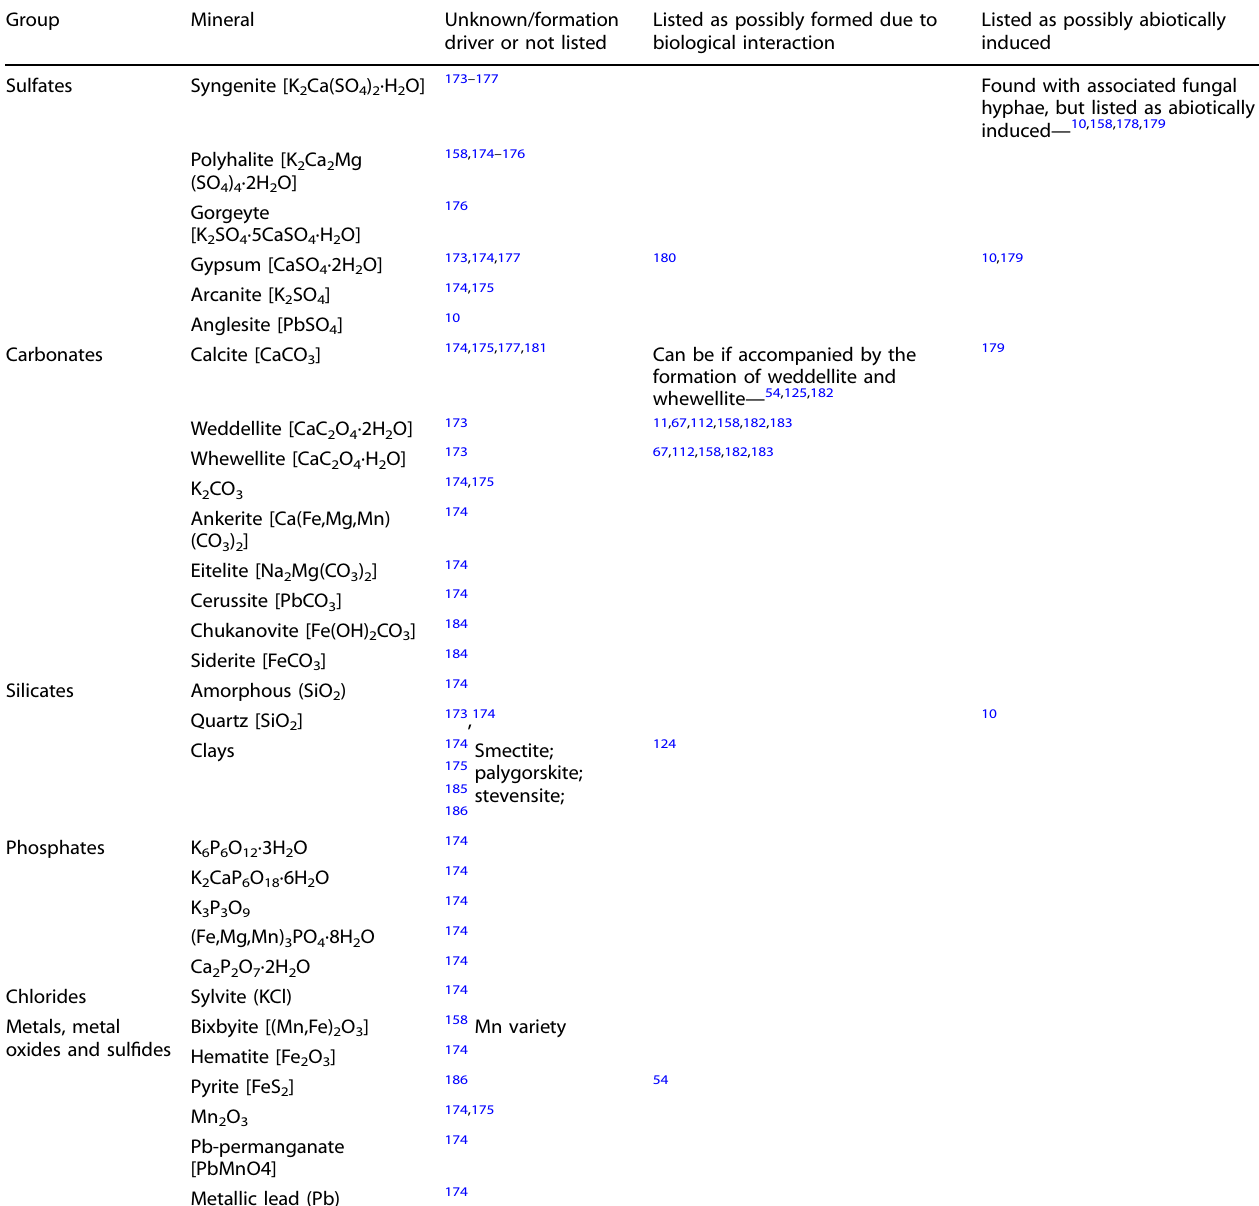
Table 3. Minerals and clays identi fi ed on or related to naturally altered glasses (focus on anthropogenic glasses). Group Mineral Unknown/formation Listed as possibly formed due to driver or not listed biological